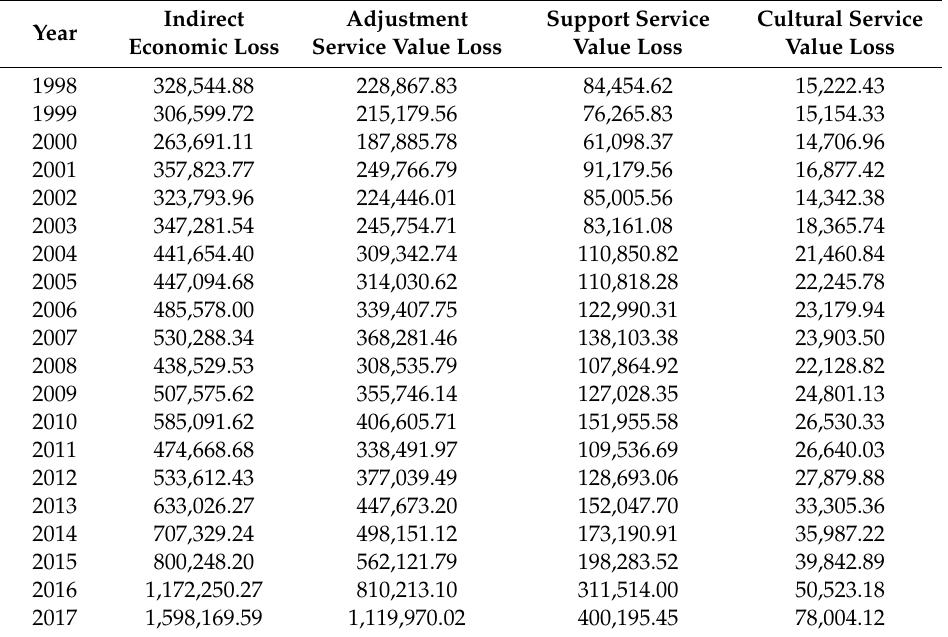
Table A6. Indirect economic losses from disease in Mainland China from 1998 to 2017 (Secondary indicators) / 10 4 CNY.